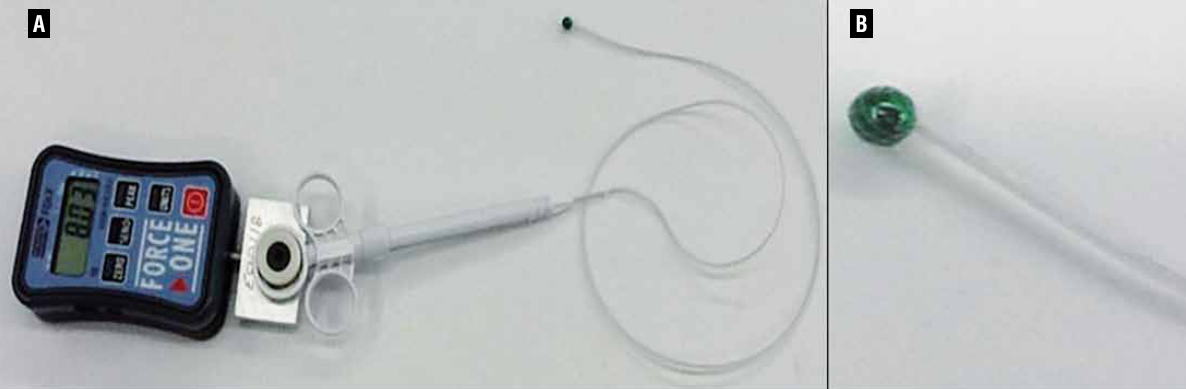
Figure 2 - Net strength testing with a force gauge handle (A) by holding a 6 mm artificial metallic bead (B) and applying a force to the handle until the net failed or handle reached its maximum